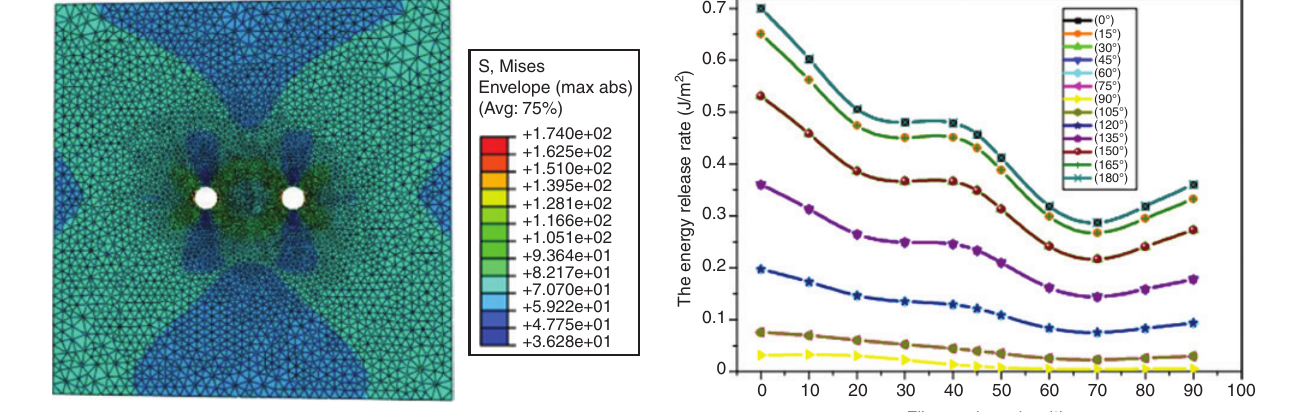
Figure 8: Variation of energy release rate in function of the fiber orientation for all orientations of the crack in the case where the two circular notches are